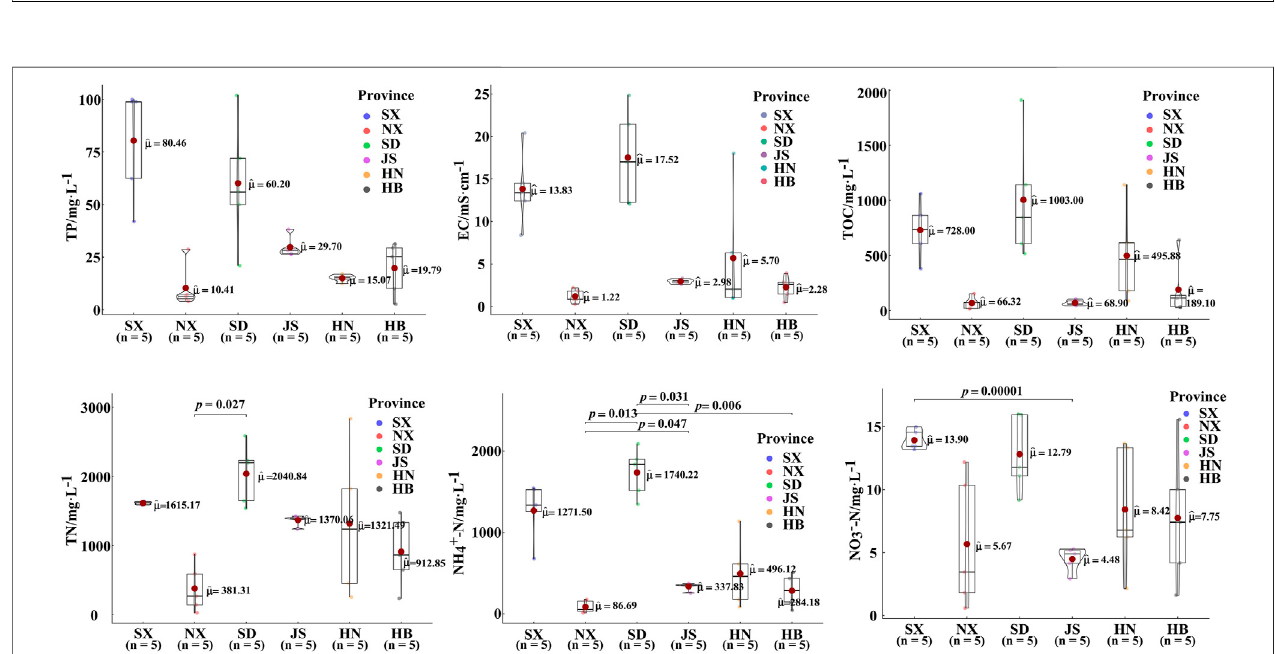
FIGURE 3 | The physiochemical indicators of three-compartment septic tank ef fl uent. The fi gure shows box plots, dot plots and violin plots of TN, TP, NH 4+ -N,